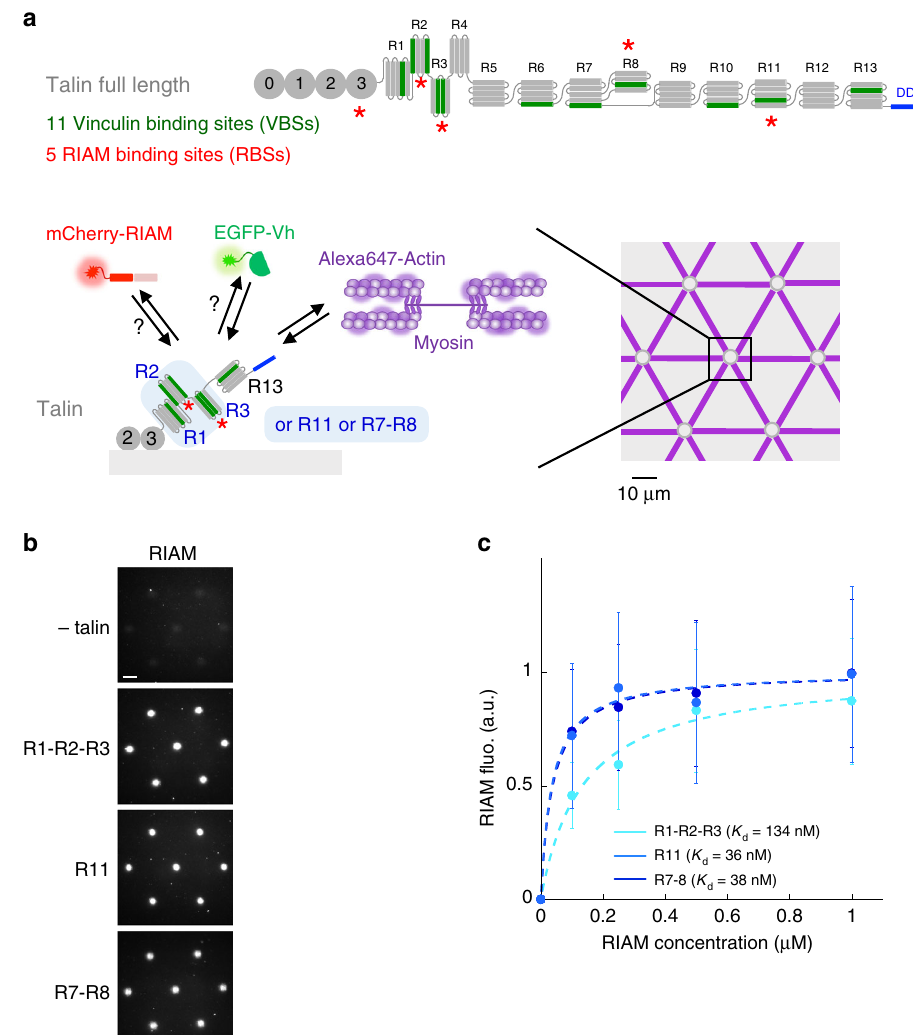
Fig. 1 In vitro reconstitution of talin – RIAM complexes. a Top panel: organization of full-length talin featuring RIAM- and vinculin-binding sites. The vinculin-binding sites (VBSs) are the dark green helices. RIAM binds to the R2, R3, R8, and R11 domains of talin. R13 is the C-terminal actin-binding domain (ABD) of talin. Bottom panels: basic principle of the in vitro microscopy assay. Alexa647-labeled actin and myosin II self-assemble to apply force to talin R1 – R2 – R3, R11, or R7 – R8 immobilized in micropatterns, which controls the binding of EGFP-vinculin head (EGFP-Vh) and mCherry-RIAM. Talin is represented as a monomer for convenience but it contains a dimerization domain (DD). b Representative images of the fl uorescence of mCherry-RIAM 1-306 (1 µ M) in non-coated control disks and disks coated with 1 µ M talin R1 – R2 – R3 or R11, or R7 – R8. Scale bar = 10 µ m. This experiment was repeated three times independently with the same results. c Binding of RIAM to disks coated with talin R1 – R2 – R3, R11, and R7 – R8. Conditions: 0 – 1 µ M mCherry- RIAM 1-306, 1 µ M of talin during the coating step. Data are mean ± SD. n = 150 disks all points, except (R1 – R2 – R3 + 0.5 µ M RIAM) n = 137 disks. Source data are provided as a Source data fi